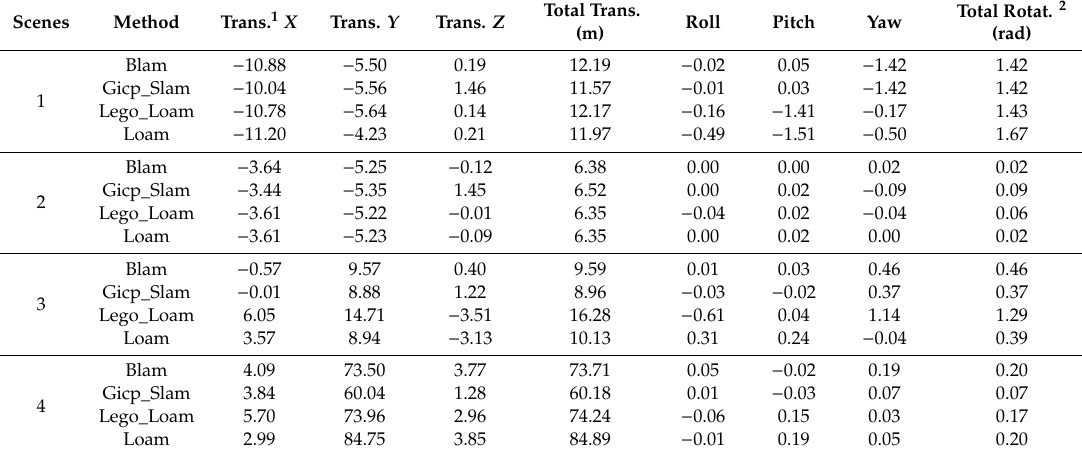
Table 1. Relative deviation results of translation and rotation of the same starting point and end point under four SLAM methods in four